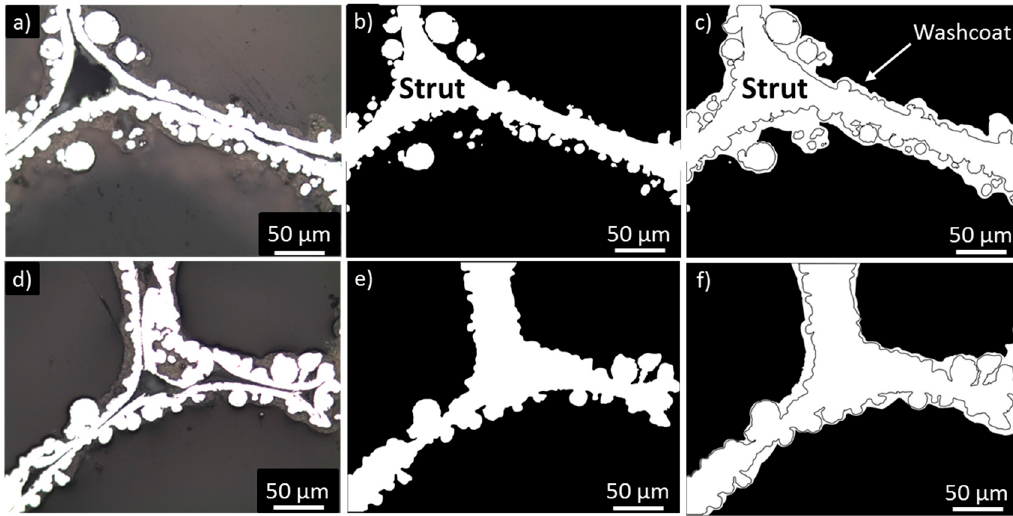
Figure 7. Image processing on cross section images of spin-coated S1200 ( a – c ) and S580 ( d – f ) foams.